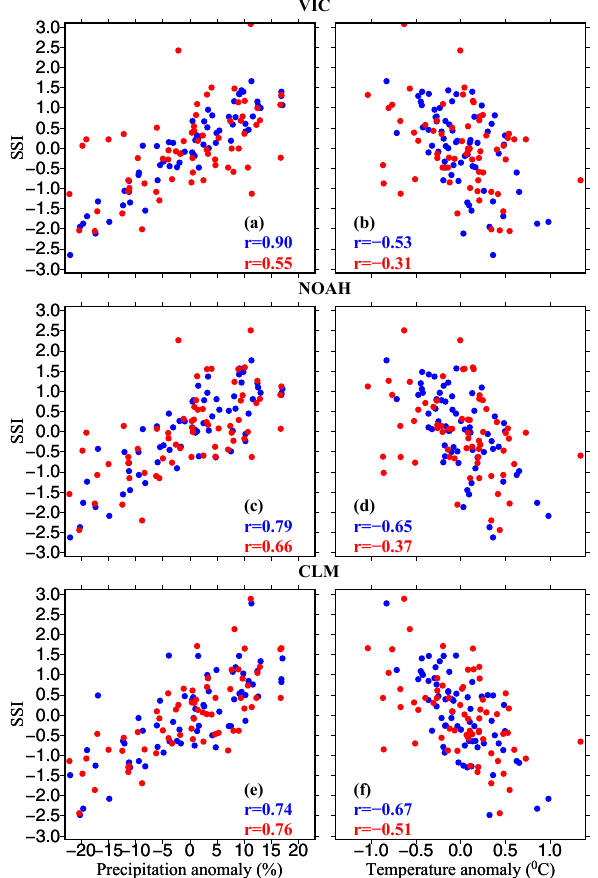
Figure 6. (a, c, e) Relationship between monsoon season precipita- tion anomaly (%) and 4-month SSI at the end of the monsoon sea- son, and (b, d, f) same as (a, c, e) but for the relationship between 4-month SSI and the air temperature anomaly of the monsoon sea- son. Correlation coefficients are shown for all-India SSI (blue) and 4-month SSI over the Indo-Gangetic Plain